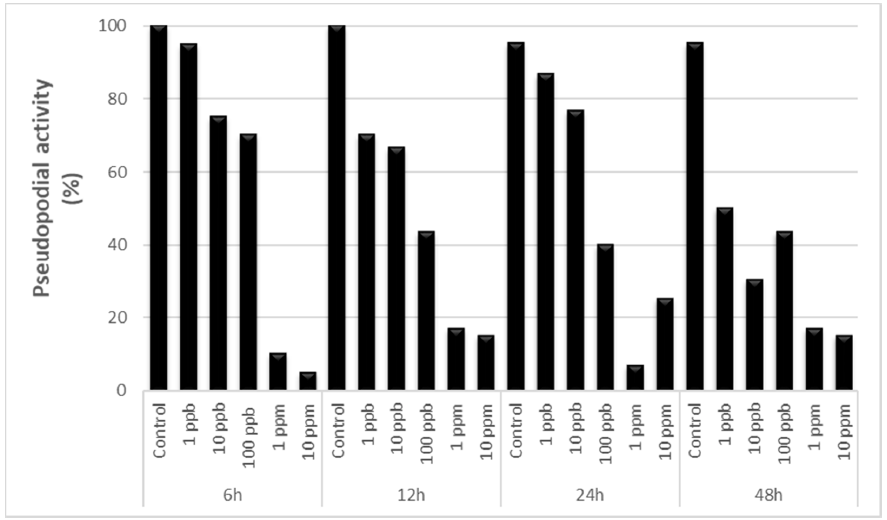
Figure 2. Histograms of percentages of A . cf. parkinsoniana specimens exhibiting pseudopodial activity for the treatments (control and five Cd-concentrations) and over time (6 h, 12 h, 24 h and 48 h).